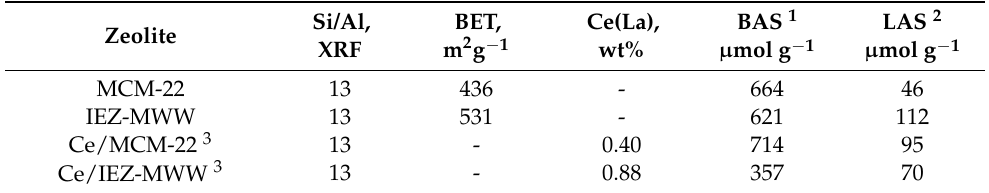
Table 7. Basic properties of the studied materials. Reprinted with permission from ref. [108]. Copyright 2014, Royal Society of